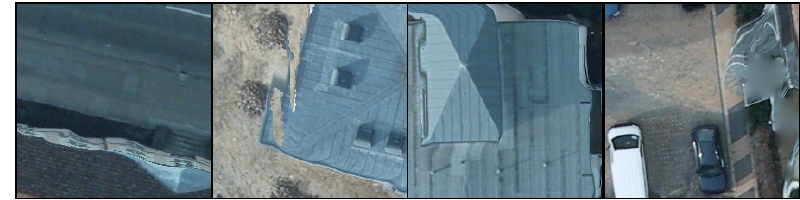
Figure 4. Example of visible distortion in RGB input